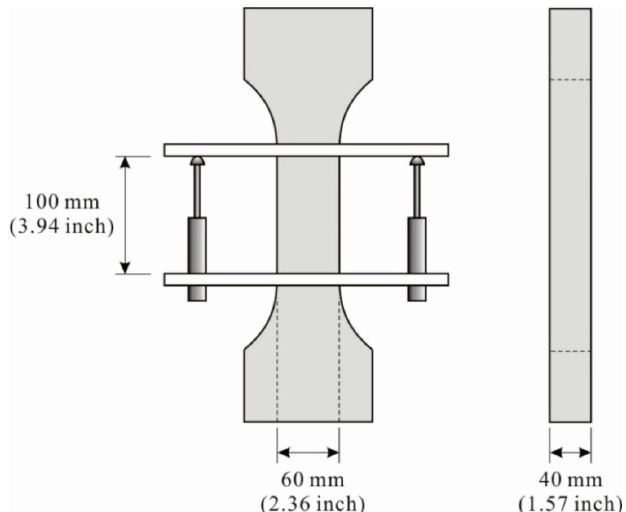
Figure 2. Specimen geometry and test setup for the direct tension test.